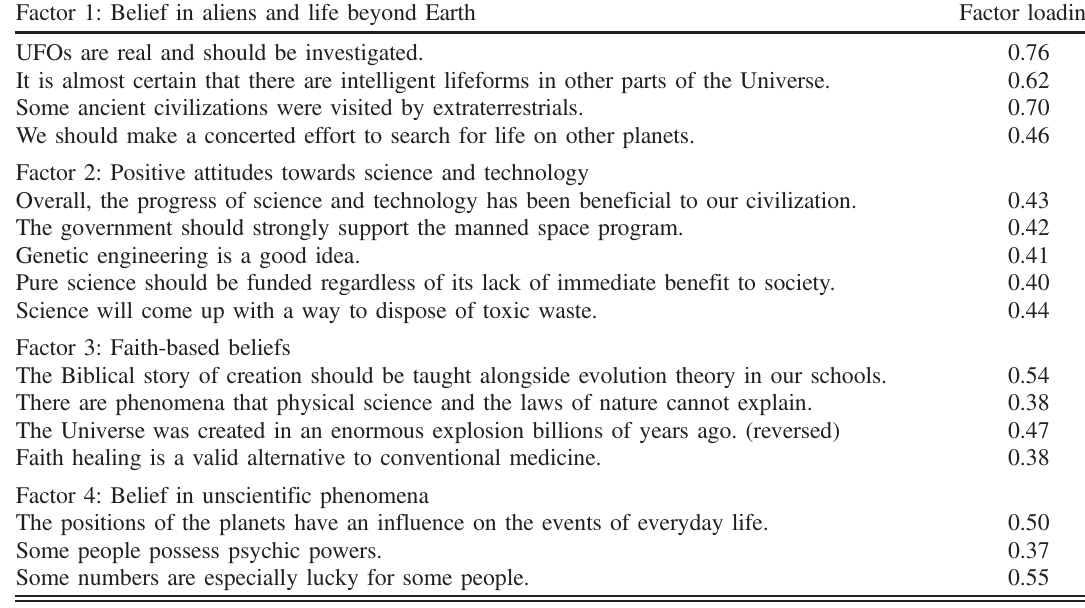
TABLE II. Salient factor loadings (above 0.35) for items retained in the model. Factor 1: Belief in aliens and life beyond